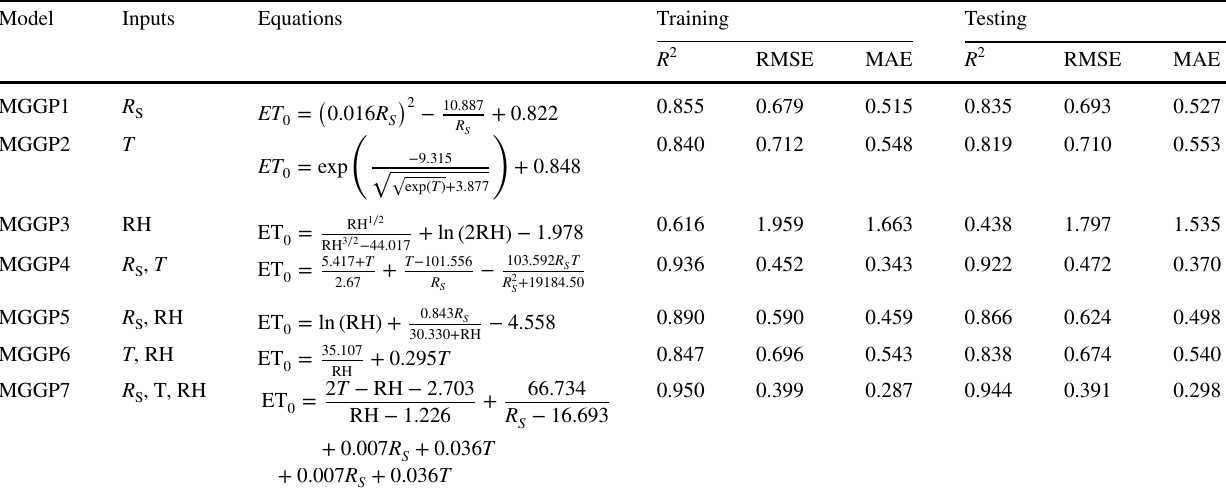
Table 4 Performance criteria obtained from the MGGP models and equations Model